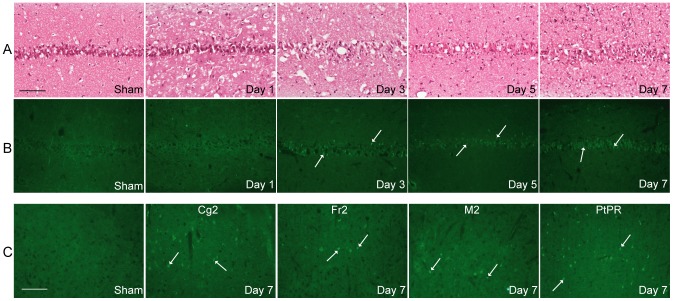
Time-course of neuronal cell death after global cerebral ischemia.Representative microphotographs of HE staining (3A) and apoptotic DNA fragmentation detected by TUNEL staining (3B) in hippocampus CA1 area from sham operated rats or ischemia induced rats at 1, 3, 5 or 7 days of reperfusion. (3C) shows microphotographs of apoptotic DNA fragmentation detected by TUNEL staining in cortex from sham-operated and ischemia-induced rats 7 days after surgery. (3A and B) shows hippocampal CA1 neurons from sham-operated rat, ischemia-reperfusion after 1 day, ischemic hippocampal CA1 neurons from day 3 after surgery, ischemia rat at day 5 and hippocampal pyramidal cells from ischemia-induced rat a week after surgery. Scale bar (100 μm) in 3A (sham) applies to all figures (3A and B), magnification of 20x. (3C) shows frontal cortex area 3 (Fr3) from sham-operated rats, cingulate cortex area 2 (Cg2) from ischemia- induced rat, Fr3 from ischemia-induced rat, secondary motor cortex (M2) from ischemic rats and parietal cortex, posterior area, rostral part (PtPR) from ischemia-induced rats. Scale bar (100 μm) in 3C (sham) applies to all microphotographs from cortex, magnification of 20x. White arrows are pointing at TUNEL positive cells. n = 3 rats in each group.